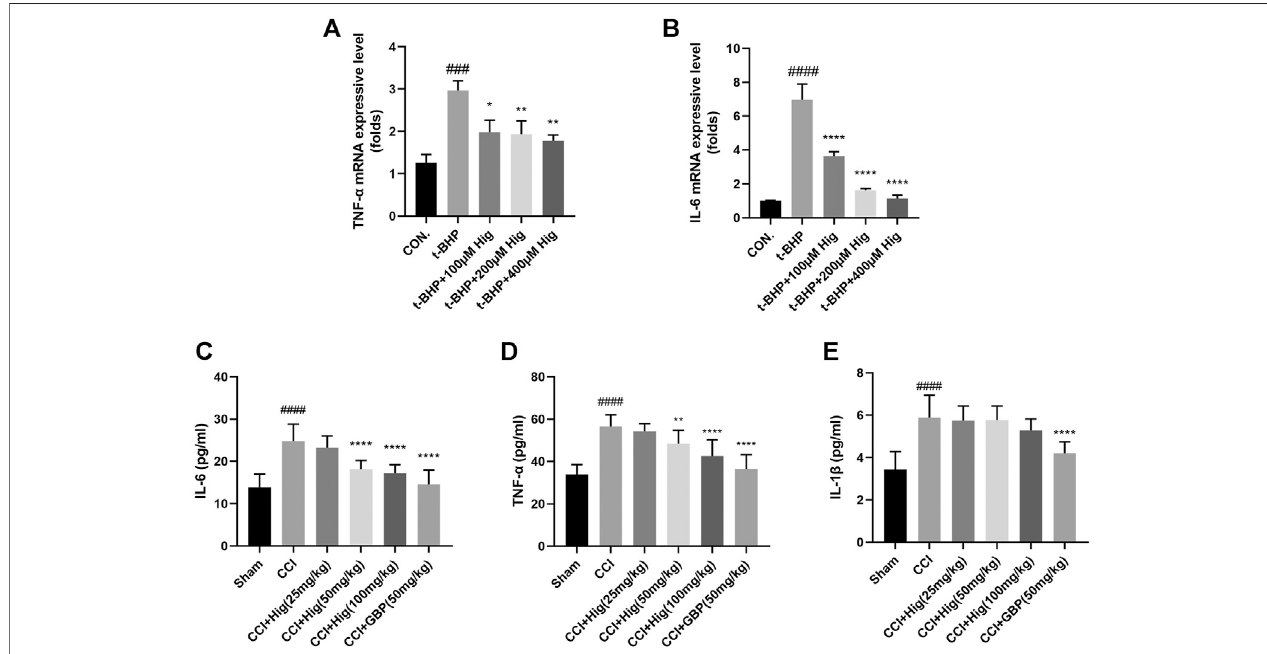
FIGURE 4 | The anti-in fl ammatory function of Hig was evaluated by its effect on the expression of in fl ammatory factors. (A, B) The RSC96 intercellular mRNA expression levels of TNF- α and IL-6 were measured by RT-qPCR. (C – E) The expression levels of TNF- α , IL-6, and IL-1 β in rats serum were detected by speci fi c ELISA kits.Theresultsarepresentedasmean ± SEM, n (cid:2) 6.### p < 0.001and#### p < 0.0001vs.thecontrolgroup.* p < 0.05,** p < 0.01,*** p < 0.001,and**** p < 0.0001vs. the model group.